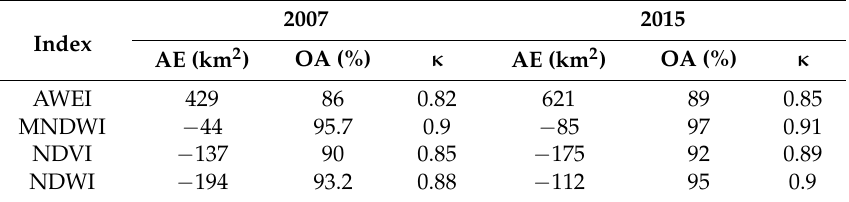
Figure 5. Performance evaluation of AWEI, MNDWI, NDVI and NDWI. ( a – d ) are binary images from AWEI, MNDWI, NDVI and NDWI respectively highlighting possible errors. ( e – h ) are water pixels overlaid on false composite of the reference image. Table 5. Accuracy assessment analyses.